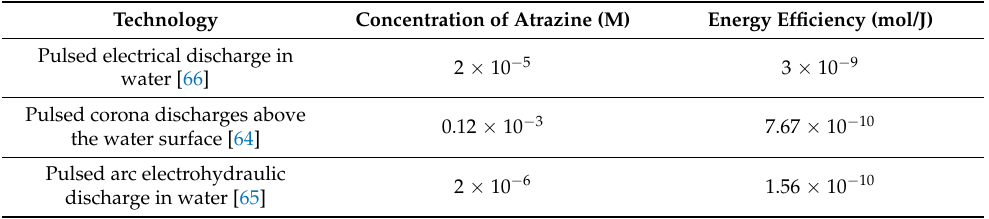
Table 7. Comparison of energy efficiency for the three pulsed electrical discharge processes.